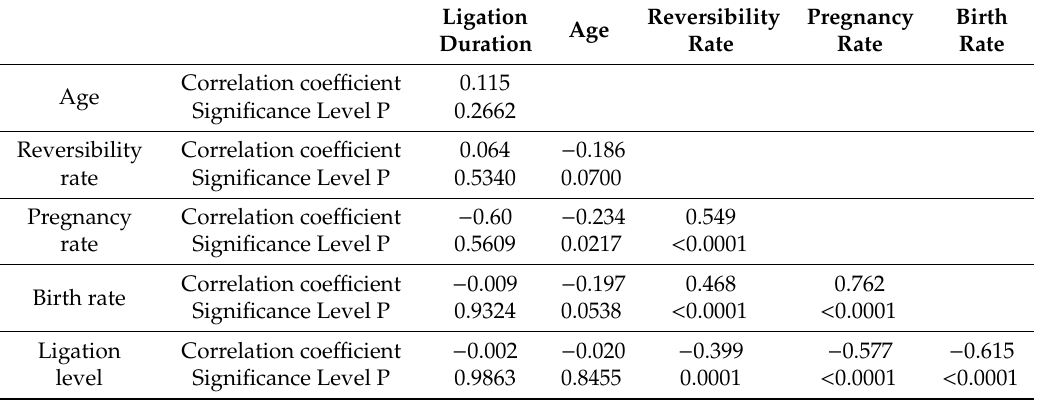
Table 2. Correlations between age group and reversibility rate, pregnancy rate, birth rate and ligation level (for the entire sample = 96 patients).